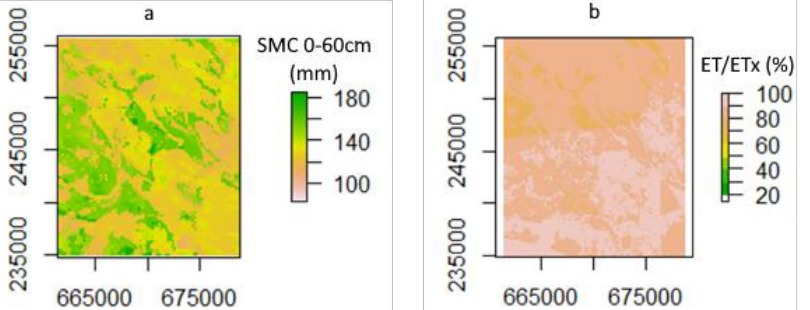
Figure 12. Spatial variation maps of daily water content for the rooting zone ( a ) and percentage of relative evapotranspiration ( b ) for 10 September 2020. (Projection: EPSG:23700.) relative evapotranspiration ( b ) for 10 September 2020. (Projection: